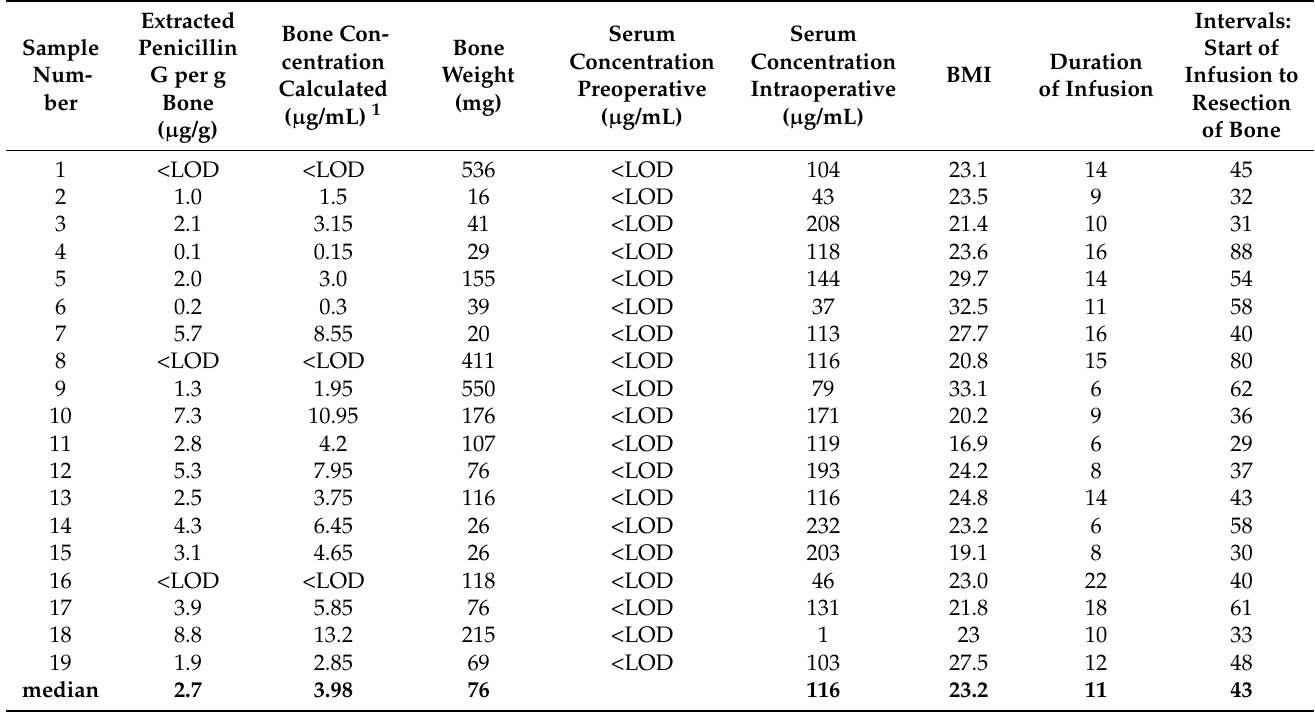
Table 1. Summary of bone and serum concentration of penicillin G, weight of bone samples, infusion parameters of penicillin G, and body mass index (BMI) of the patient